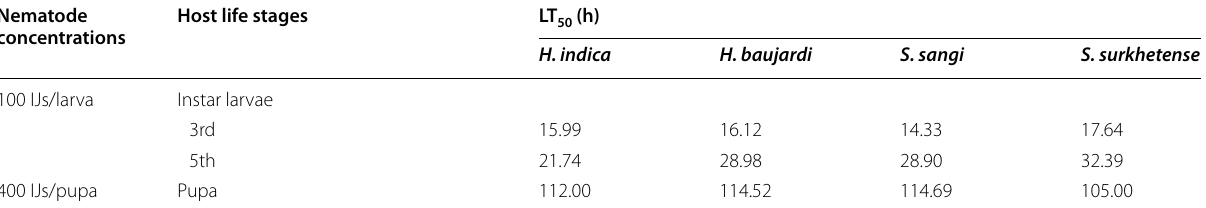
Table 2 Lethal time (LT ) for the four isolated EPN species against S. frugiperda 50 Nematode Host life stages LT 50 concentrations